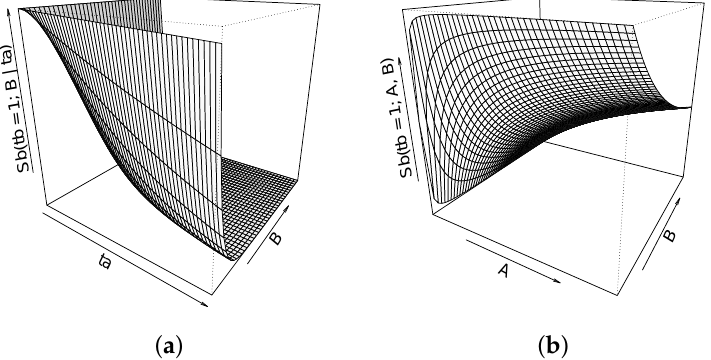
Figure 1. ( a ) The survivor function for T b conditioned on t a in example 1. S b ( t b = 1; B | t a ) decreases with increases in t a and B . ( b ). The marginal survivor function for T b in example. S b ( t b = 1; B ) increases with A and decreases with B